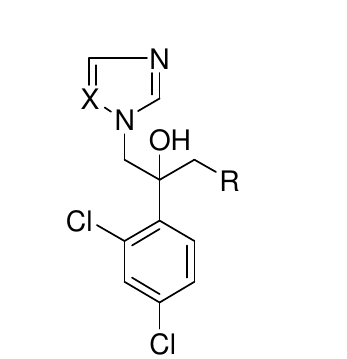
Figure 8. Structure of imidazolyl and 1,2,4-triazolyl carbinols.